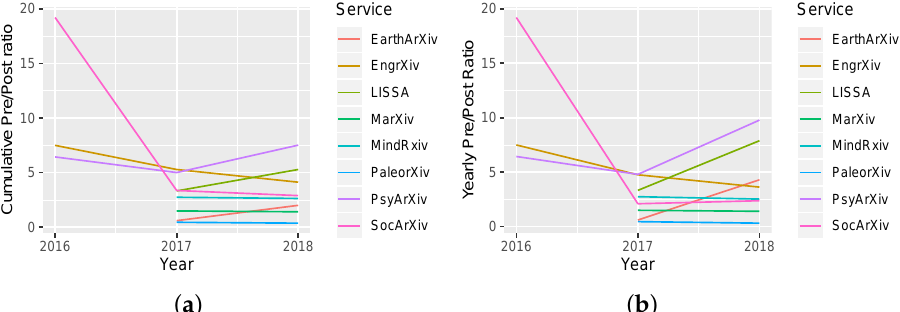
Figure 2. Temporal evolution of ratio between preprint submission to postprint submissions. ( a ) cumulative ratio ( b ) single year